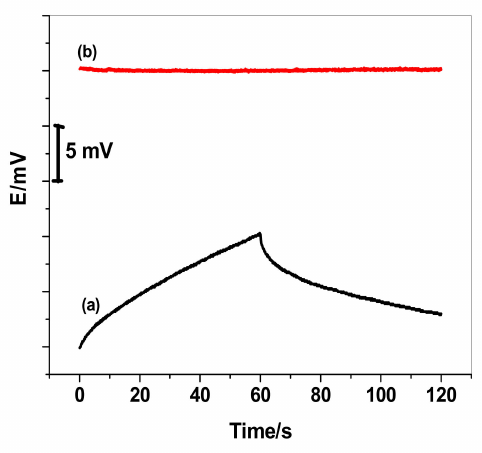
Figure 5. Chronopotentiograms of ( a ) SPE/MIP-ISE and ( b ) SPE/MWCNTs/MIP-ISE.